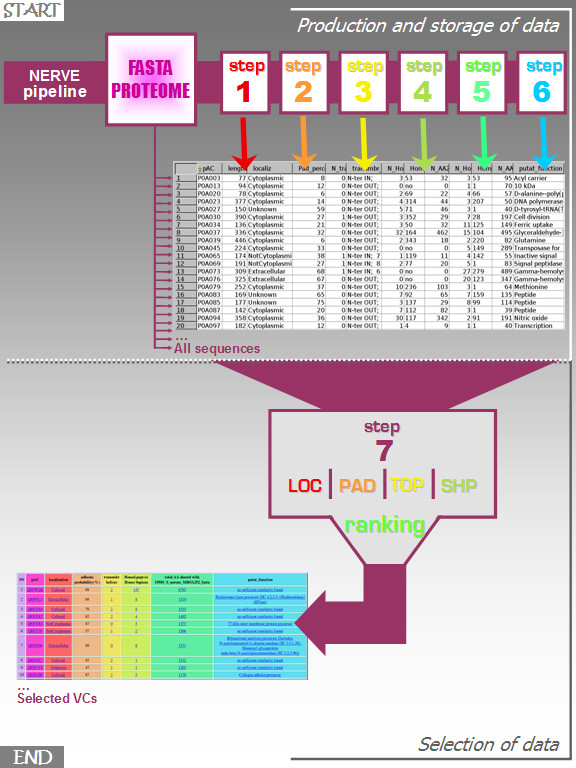
NERVE software pipeline. The process can be divided into two parts: data production and storage (top) and data selection (bottom). Six different scripts screen the entire proteome to mine and infer information that flows into a MySQL table. A seventh script uses four filters (LOC, localization; TOP topology; PAD, probability of being adhesin; SHP, similarity to human proteins) and analyzes values created by steps 1 through 5 to select and rank VCs that are then presented in a html table with links to relevant data.